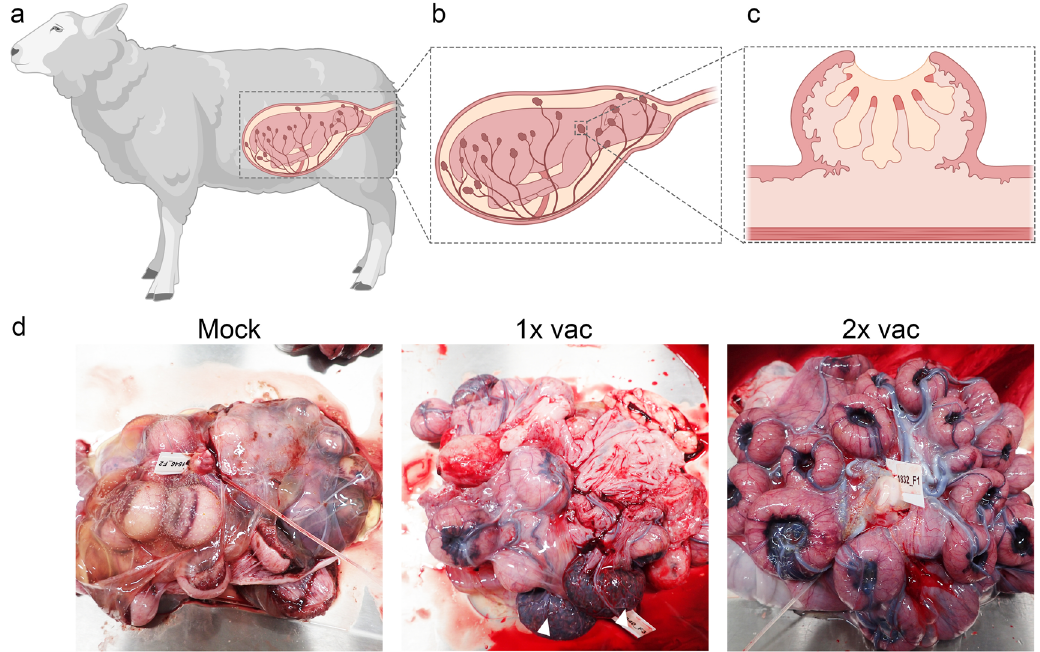
Fig. 2 Macroscopic assessment of placentas from mock-vaccinated ewes and ewes vaccinated with vRVFV-4s followed by challenged with wild-type RVFV. a Cartoon of a pregnant ewe including a magni fi cation of the ovine placenta ( b ) with placentomes and a magni fi cation of a single placentome ( c ), revealing the foetal (beige) and maternal (pink) villi and haemophagous zone (red). d Representative pictures of placentas from a mock-vaccinated challenged ewe (left panel; ewe #1846, foetus #F2), a challenged ewe that was vaccinated once (middle panel; ewe #1840, foetus #F3), and a challenged ewe that was vaccinated twice (right panel; ewe #1832, foetus #F1). Note the two type D placentomes in the placenta of the 1× vaccinated ewe (white arrowheads in middle panel, see also Supplementary Fig. 2). The cartoons in a , b and c were created using